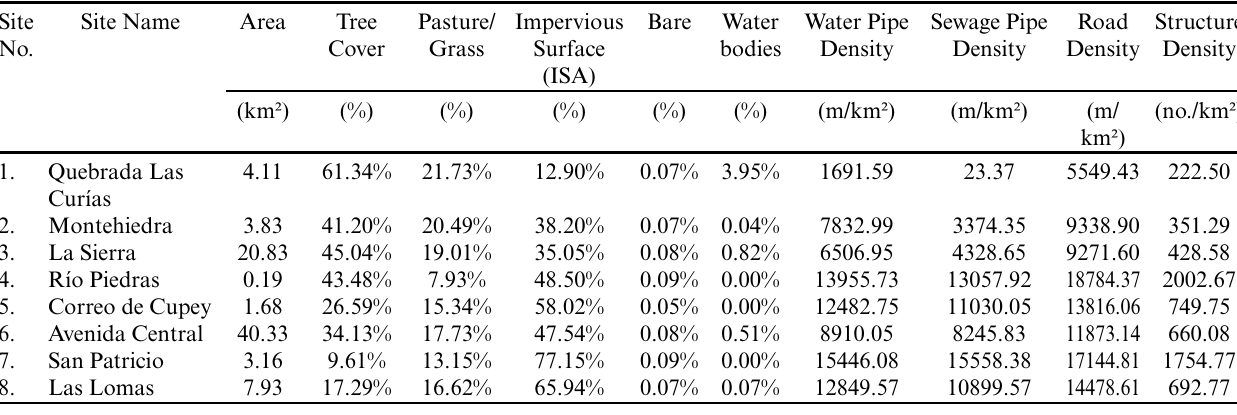
Table 1 . Land cover and structure densities for each study subwatershed in the Río Piedras watershed. Sites are ordered by increasing percent impervious surface